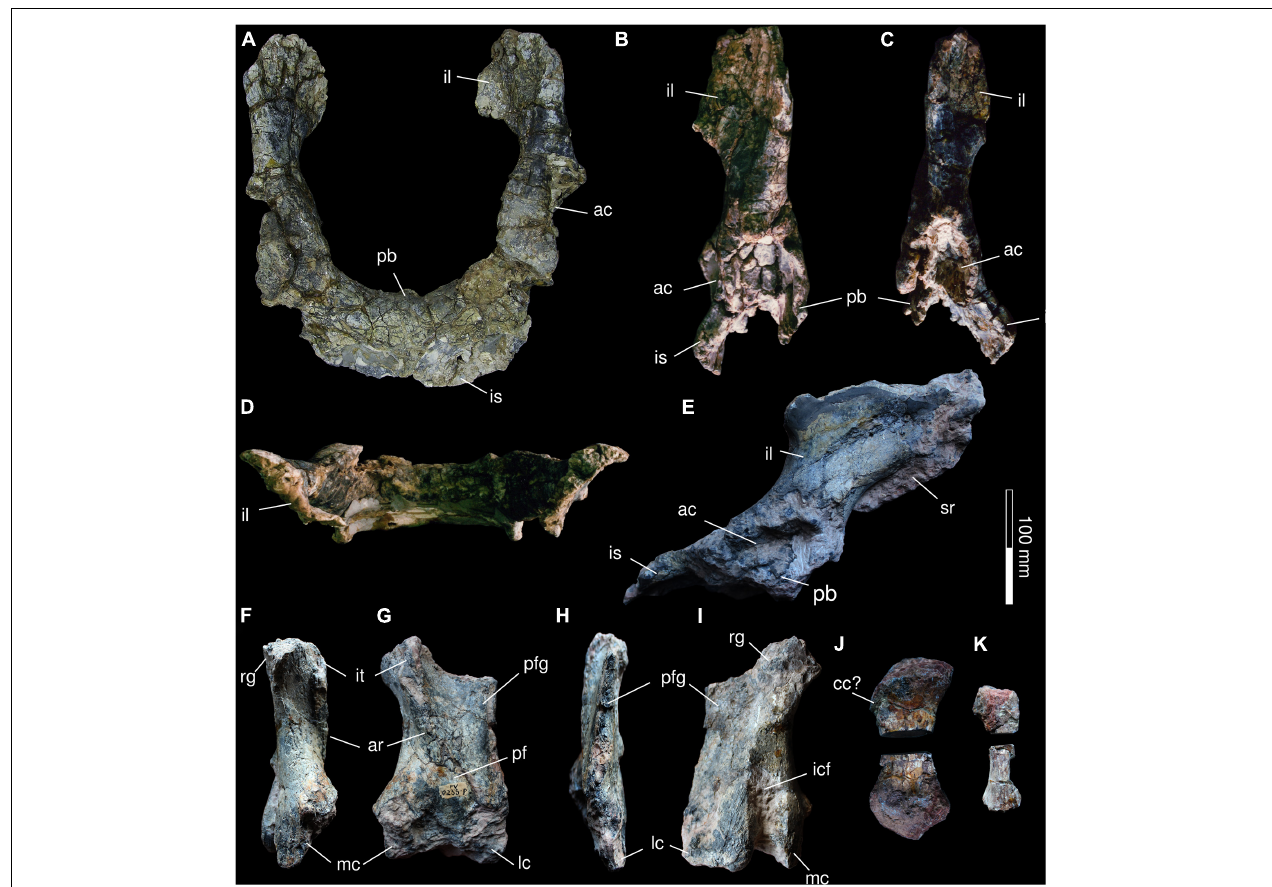
FIGURE 11 | Pelvis and hind limb of Provelosaurus americanus . (A–D) UFRGS-PV-0232-P, pelvis in (A) anterior, (B) right lateral, (C) left lateral, and (D) dorsal view (anterior to the top). (E) UFRGS-PV-0233-P, pelvis in right lateral view. (F–I) Right femur in (F) anterior (preaxial), (G) ventral (flexor), (H) posterior (preaxial), and (I) dorsal (extensor) views. (J) Right tibia in medial (flexor) view. (K) Right fibula in medial (flexor) view. ac, acetabulum; ar, abductor ridge; cc, cnemial crest; icf, intercondylar fossa; il, ilium; is, ischium; it, internal trochanter; lc, lateral condyle; mc, medial condyle; pb, pubis; pf, popliteal fossa; pfg, postaxial flange; rg, ridge; sr, first sacral